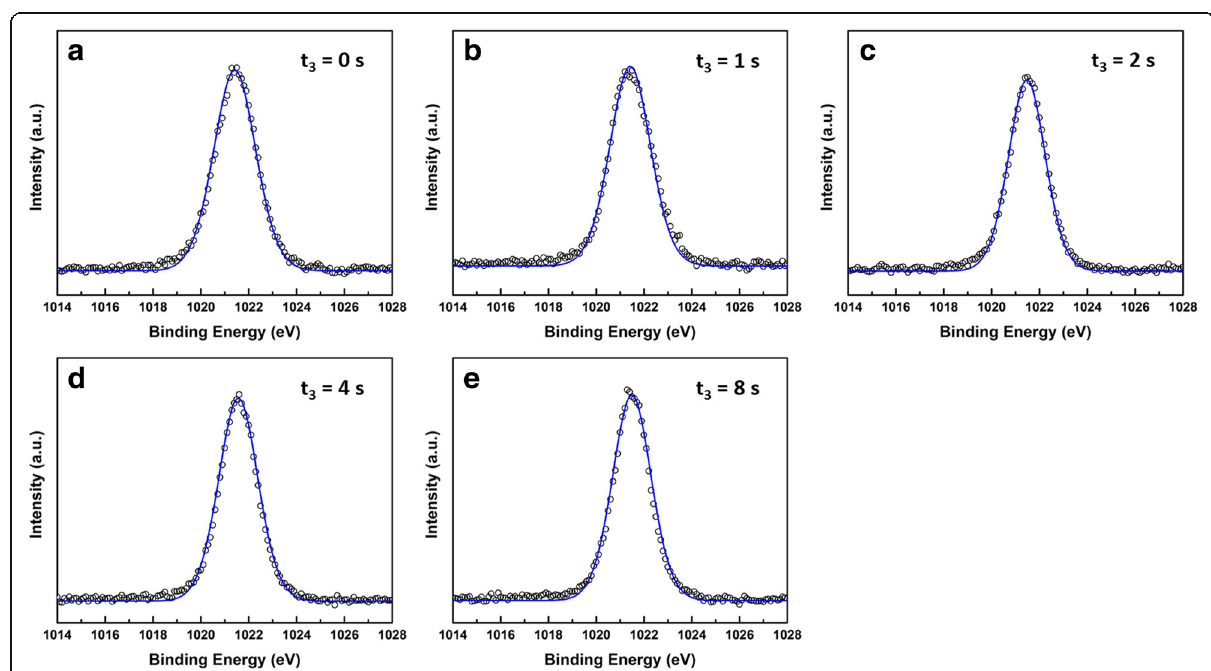
from 0 to 8 s and fixed thermal cycle ( m = 1)